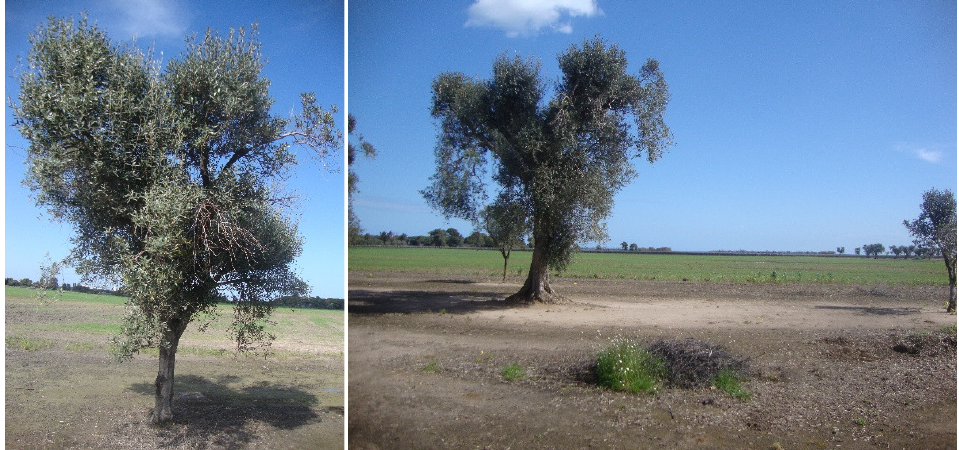
Figure 8. Situation in early autumn 2017 at San Pietro Vernotico (Brindisi province) after the eradi- cation of about 900 olive trees that surrounded eight olive trees infected by Xylella fastidiosa subsp. pauca , carried out during autumn 2015. The trees in the figure were left in place at the border of the eradication area (in the background) since they were more than 100 m away from the infection front. In early autumn 2017, all the remaining trees resulted symptomatic and positive for X. f. subsp. pauca. The spontaneous plants not eliminated during the eradication could have acted jointly as a “reservoir” for the possible vector activity in the area for the further pathogen spread in the area.